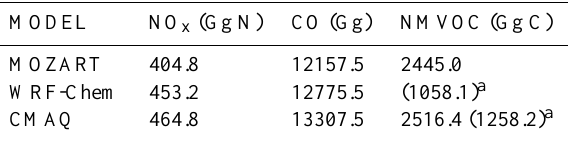
Table 1. Total emissions of ozone precursors over East Asia (15– 50 ◦ N, 95–160 ◦ E) in March in the individual models.